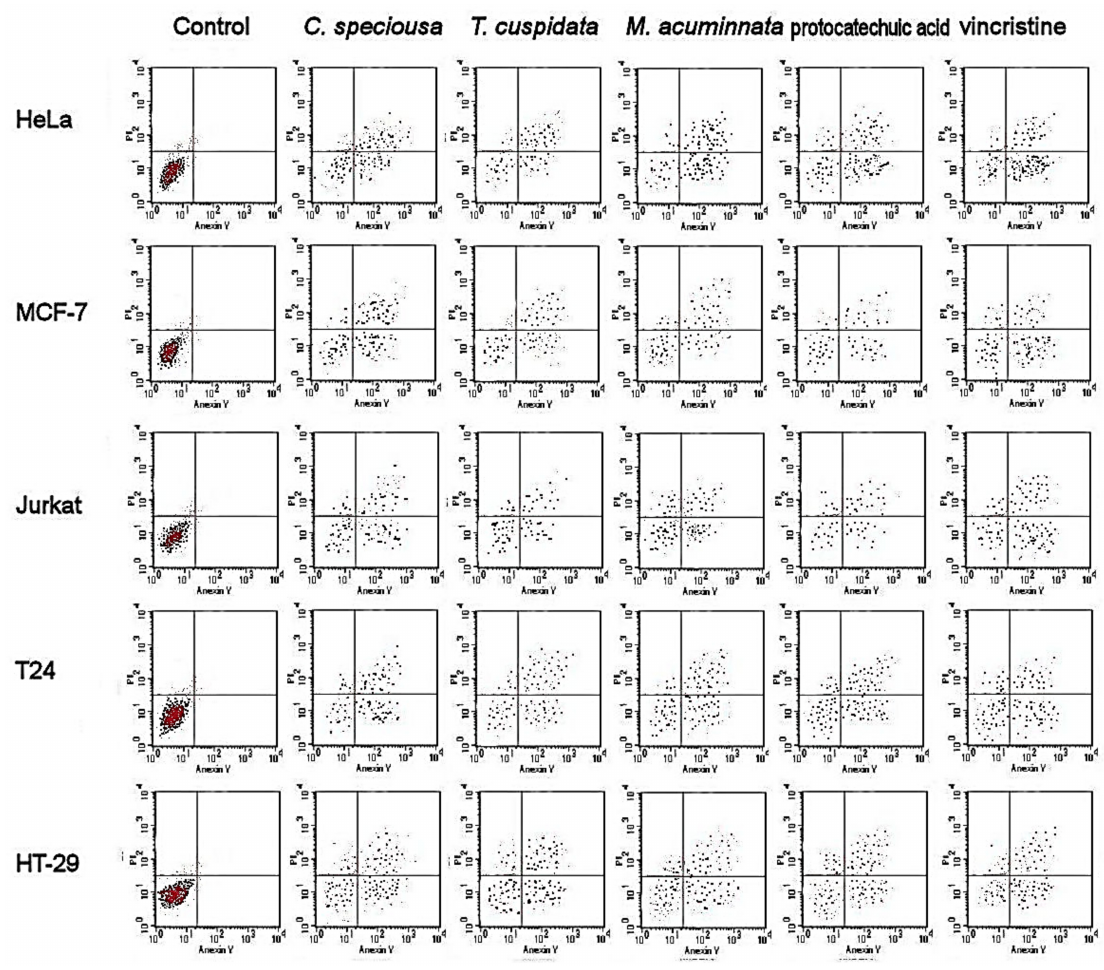
Figure 2. Cellular apoptosis induced in cancer cells at 48 h following treatment with bark extracts and catechin. Lower left, viable cells; upper left, necrotic cells; lower right, early apoptotic cells; and upper right, late apoptotic cells.